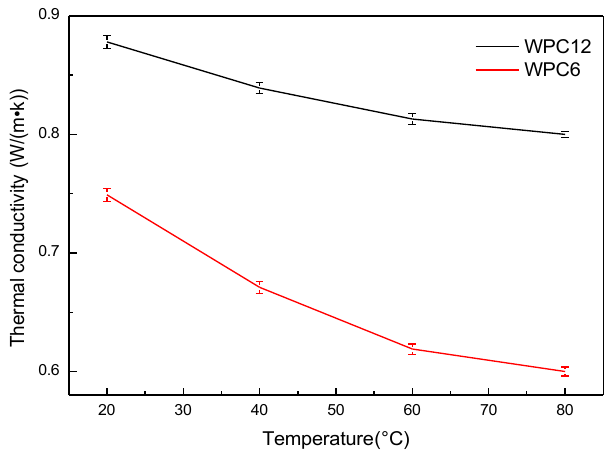
Figure 3. Thermal conductivity of the WPCs as a function of temperature.